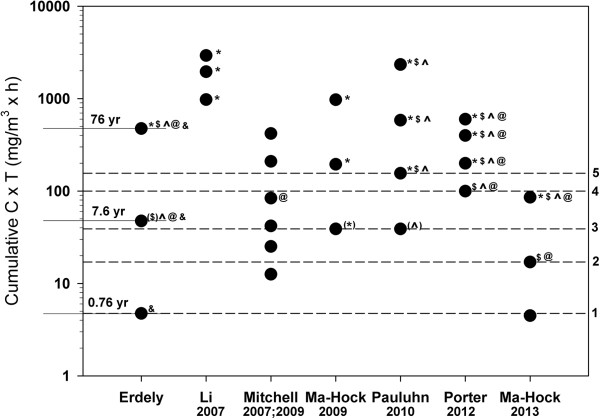
Comparison of effects among studies of inhalation exposure to multi-walled carbon nanotubes (MWCNT). Cumulative MWCNT exposures (concentration (C) x time (T) – mg/m3 multiplied by total hours of exposure) were plotted on a logarithmic scale from studies that exposed rodents by inhalation to various doses of MWCNT (black circles). Measured toxicologic endpoints were identified for each cumulative exposure. Symbols represent histopathologic alterations (*), increased bronchoalveolar lavage (BAL) polymorphonuclear cell (PMN) influx or enzyme activity ($), increased BAL total protein or albumin (^), increased tissue or BAL cytokines (@), and alterations in mRNA expression (&). The lack of a symbol means either the endpoint was not measured or there was no effect due to treatment. Symbols in parantheses indicate either a transient effect, the effect was scored as minimal, or the response was not consistently measured at all post-exposure time points for that given cumulative C x T. Each of the 5 toxicologic endpoints were highlighted by an arbitrary cutoff (dashed lines) to illustrate the threshold cumulative C x T to result in significant pulmonary responses in general agreement across various study designs. The numbers representing the dashed lines are as follows: 5 – histological alterations, 4 – increased BAL PMN influx or enzyme activity, 3 – increased BAL total protein or albumin, 2 – increased tissue or BAL cytokines, and 1 – alterations in mRNA expression. The years indicated on the left side of the graph are the extrapolations of the mouse lung burden from this study to represent years of worker exposure to an inhalable elemental carbon concentration of 10.6 μg/m3 assuming 25% respirability which predicts a MMAD of 5.5 μm.